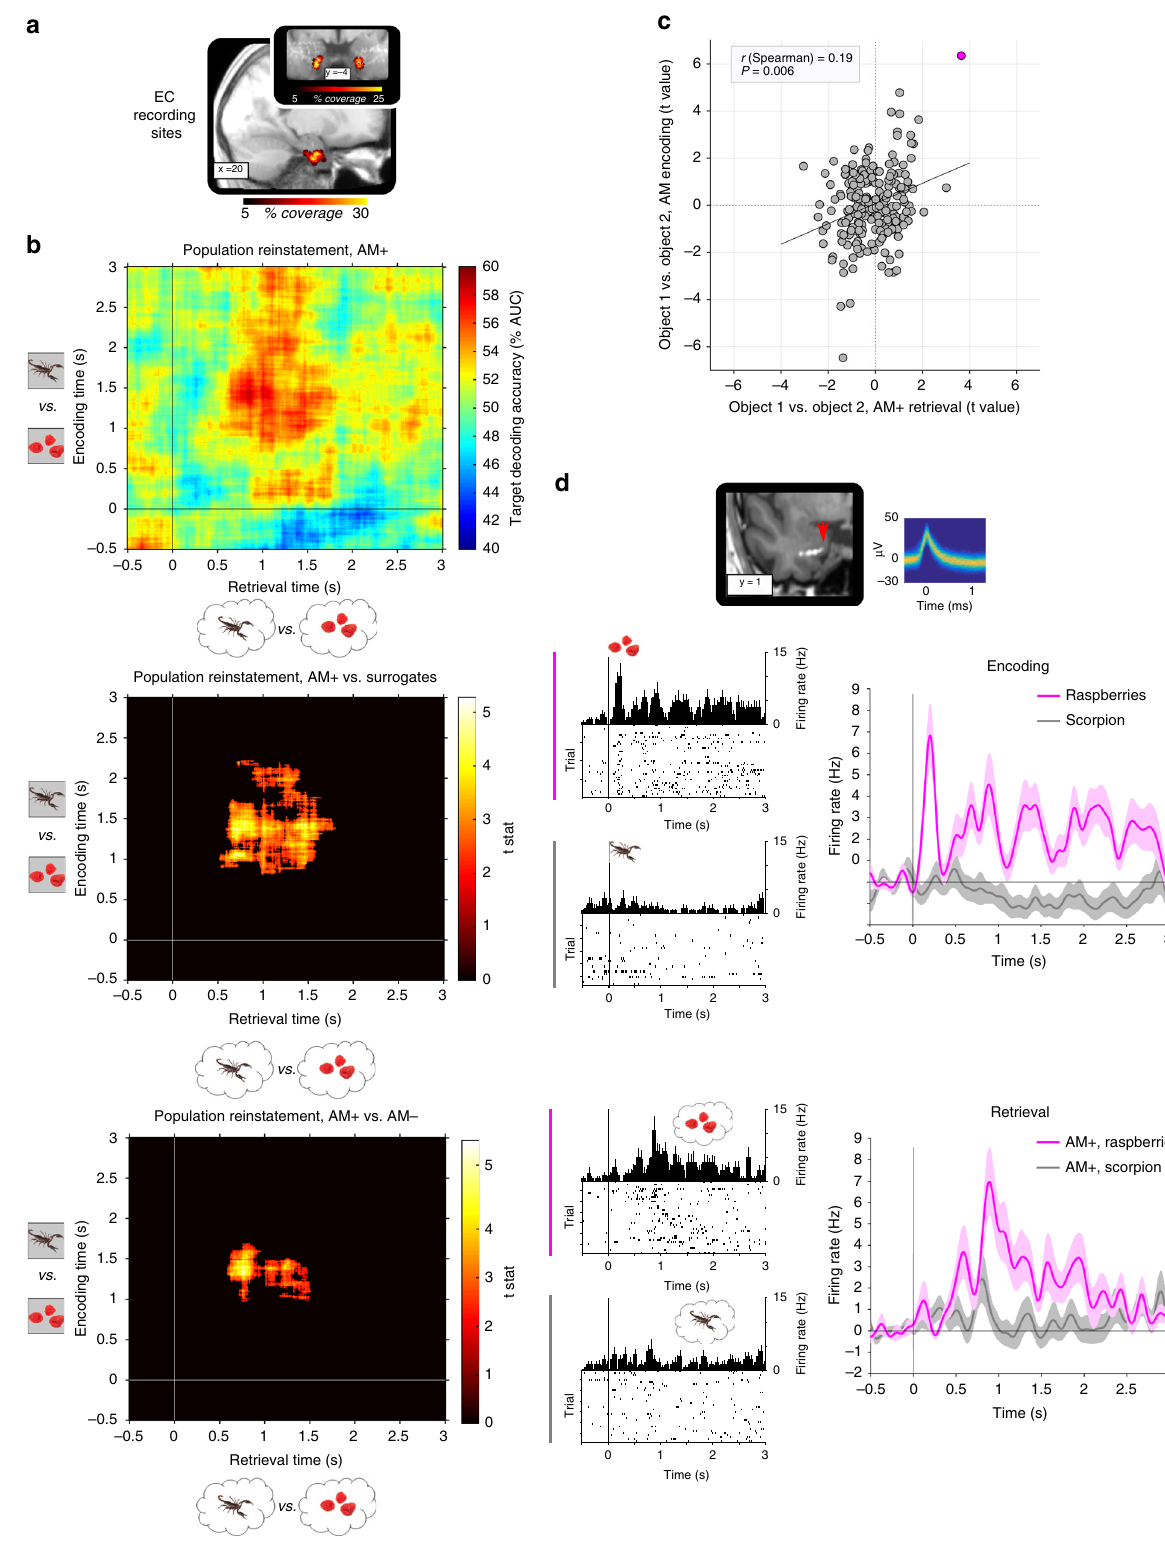
combinations of hippocampus/EC neurons in each participant, including spikes across the entire 0 – 3 s retrieval period. To control for trial-invariant fi ring properties across neurons, a ‘ shift-predictor ’ baseline CCG was derived by scrambling trial